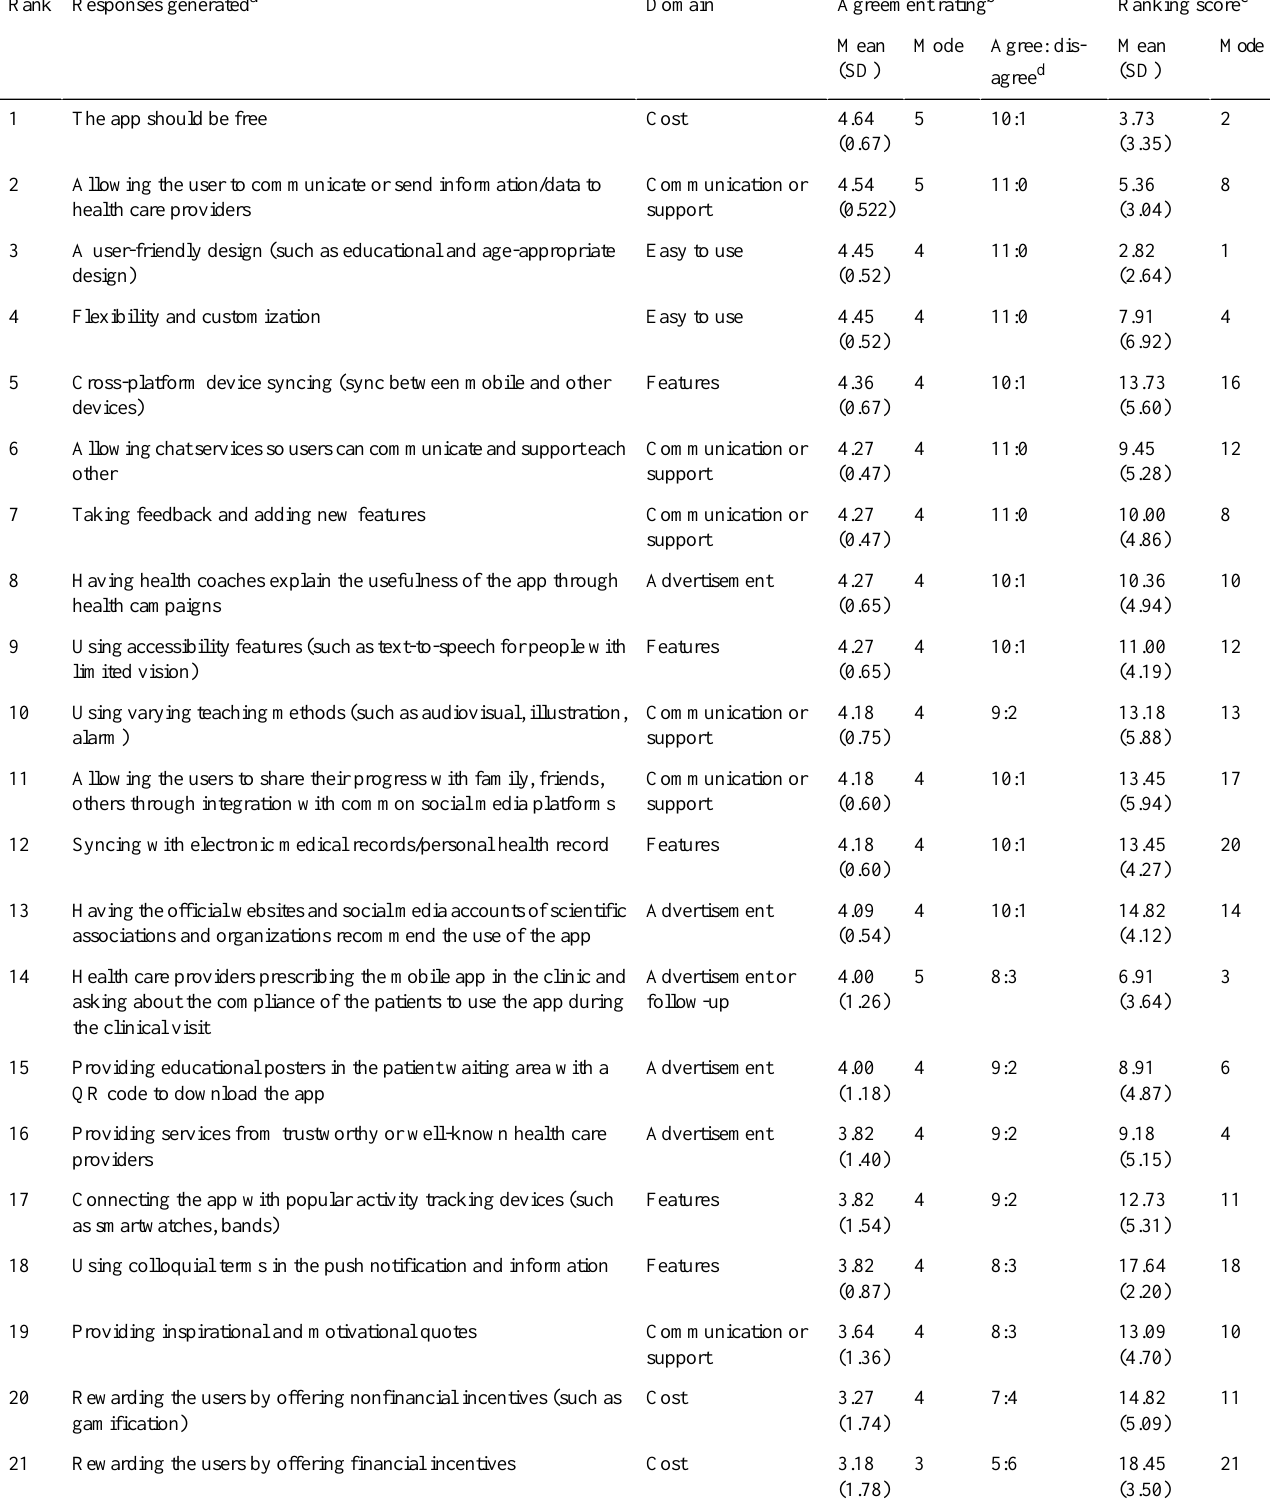
Table 3. Responses generated by the expert group concerning engagement